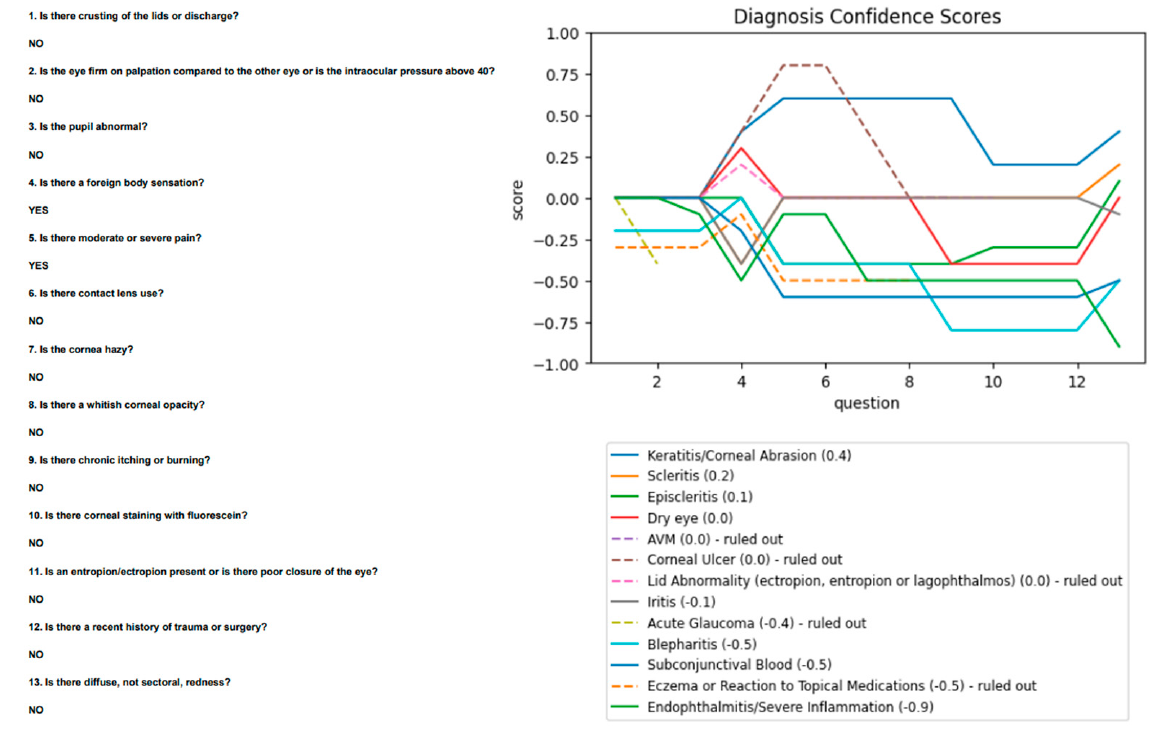
Figure 6. “Scleritis” case, using data from Ophthalmology.